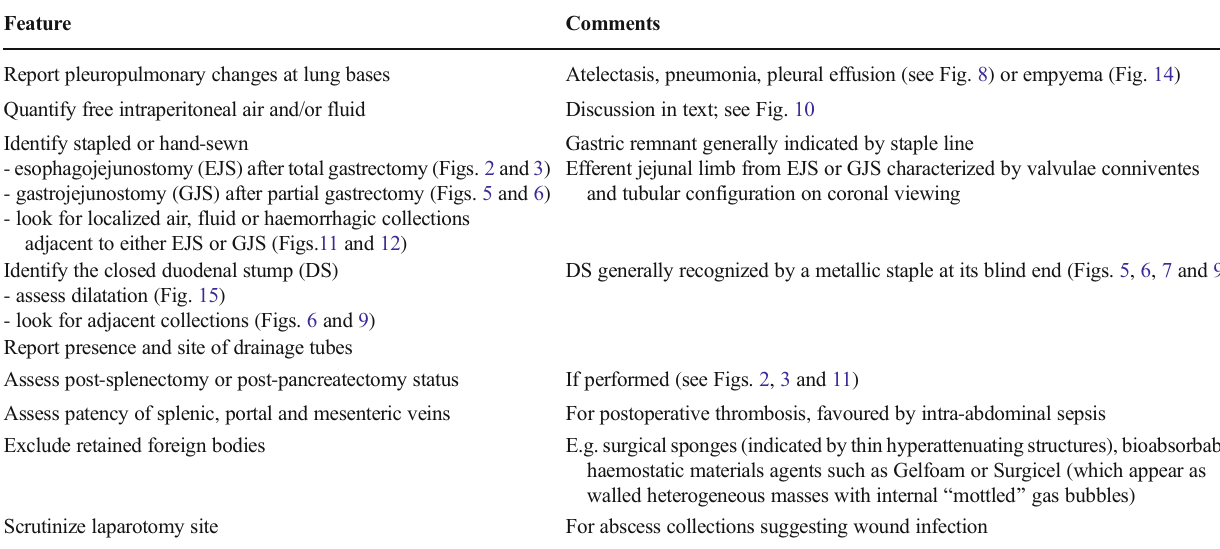
Checklist for interpretation of early post-gastrectomy CT Feature